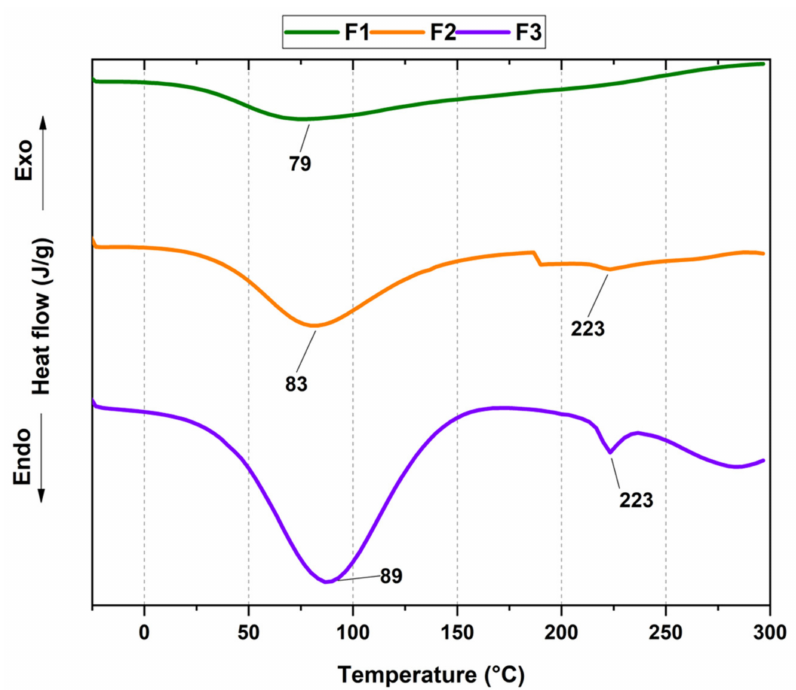
Figure 2. DSC thermal analysis of the composites.